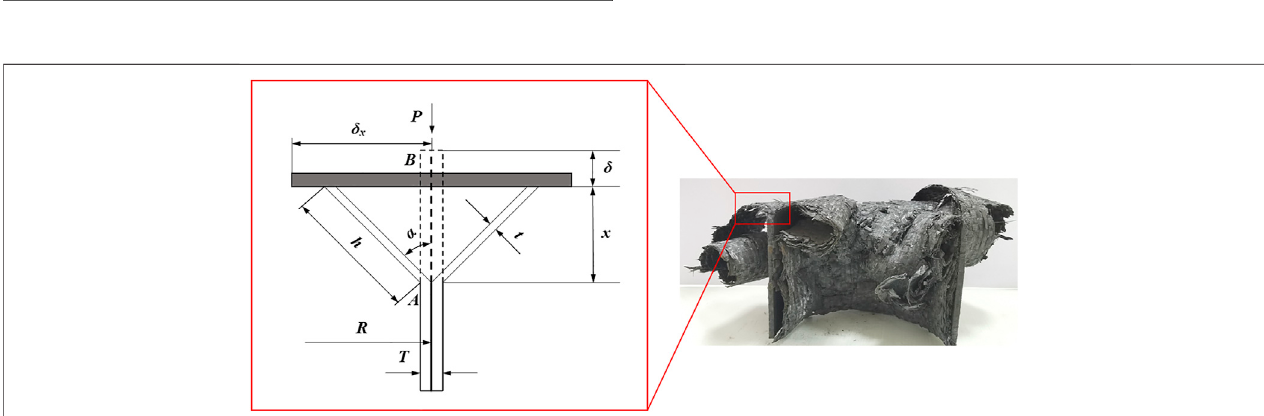
FIGURE 12 | Analysis model of the CFRP tube subjected to axial